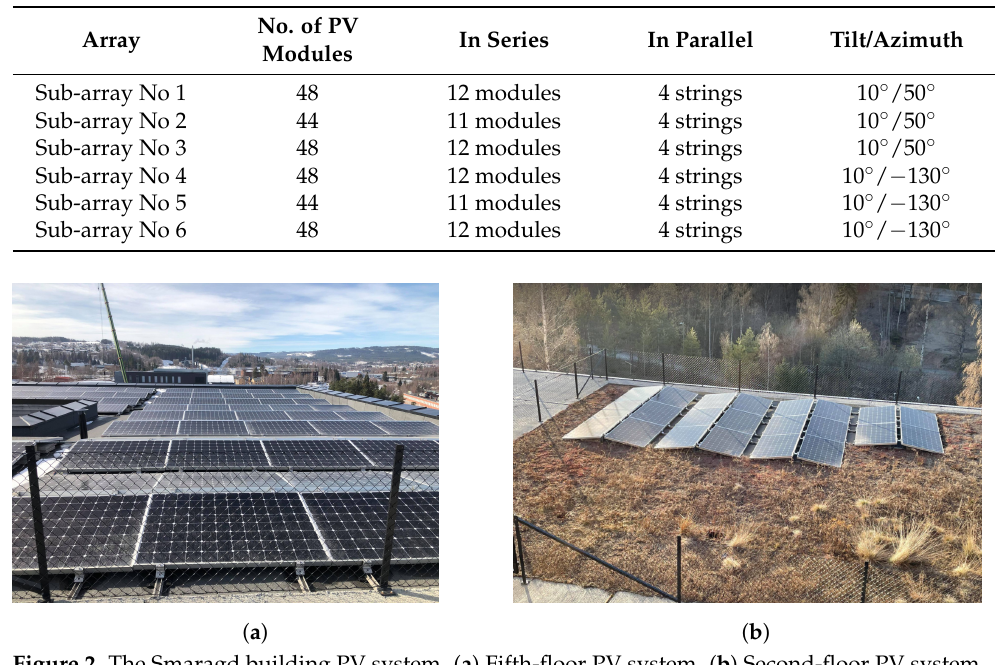
Table 3. Solar PV array description.